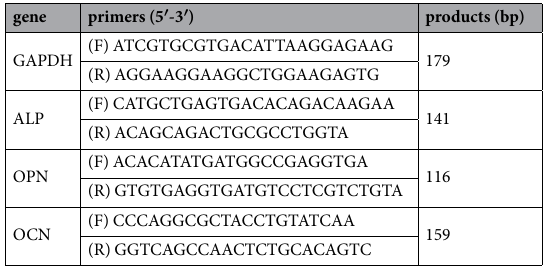
Table 1. Real time PCR primers.